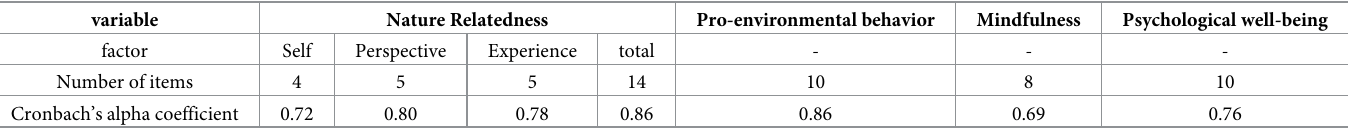
Table 2. Cronbach’s alpha coefficient of questionnaire variables.